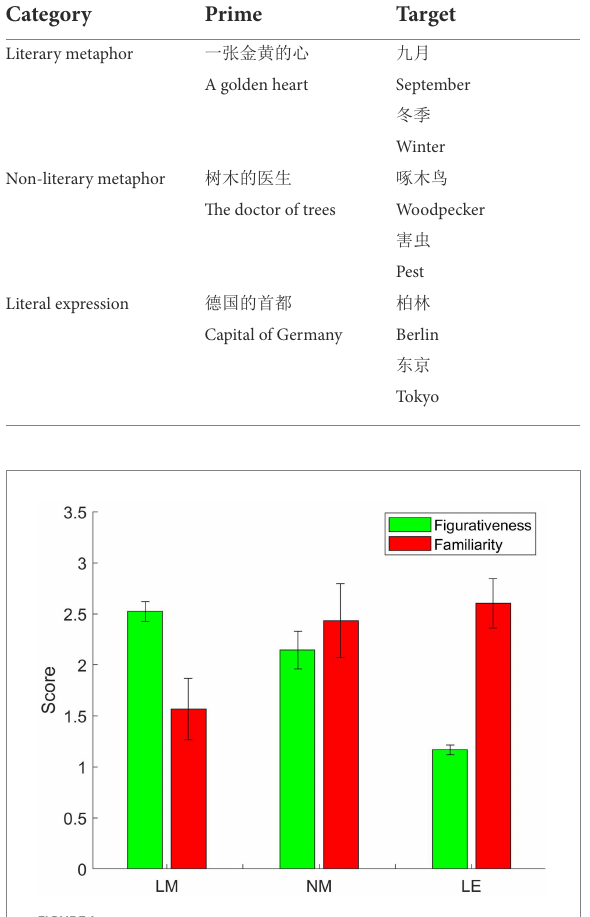
FIGURE 1 Figurativeness and familiarity of the experimental materials (LM, literary metaphors; NM, non-literary metaphors; LE, literal